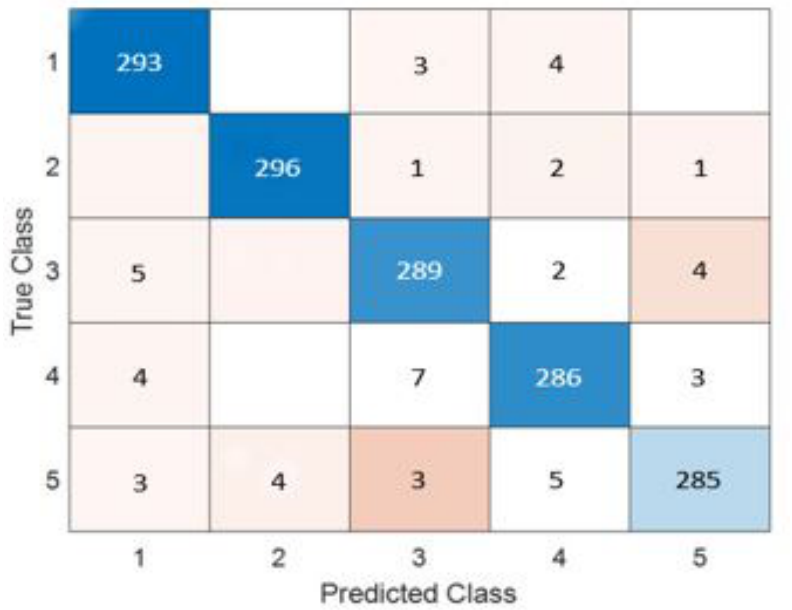
Figure 7. Confusion matrix for InceptionResNetv2-MCSVM-based model with image SR using dataset